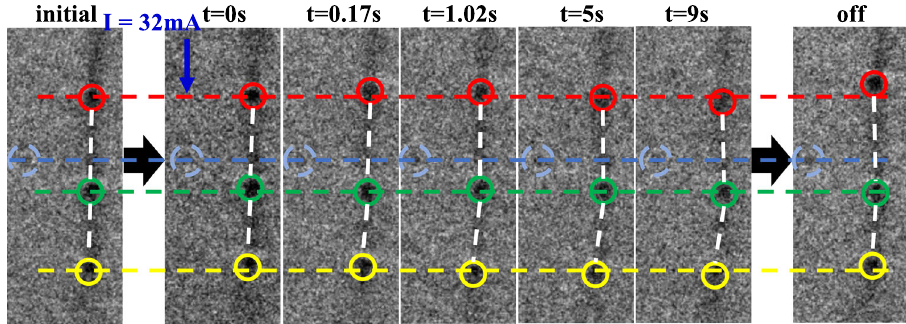
Fig. 5 The skyrmion motion in the domain wall driven by an electric current at room temperature in Gd 15 + x (Fe 94 Co 6 ) 85 − x ( x = 0.7). L-TEM images showing the skyrmion motion after turning on the electric current of 32 mA for the different time periods, respectively. The blue circle for the fi xed defect is marked out to identify the relative movement of the skyrmions on the domain wall. The relative movement of the three skyrmions is demonstrated with different colors,